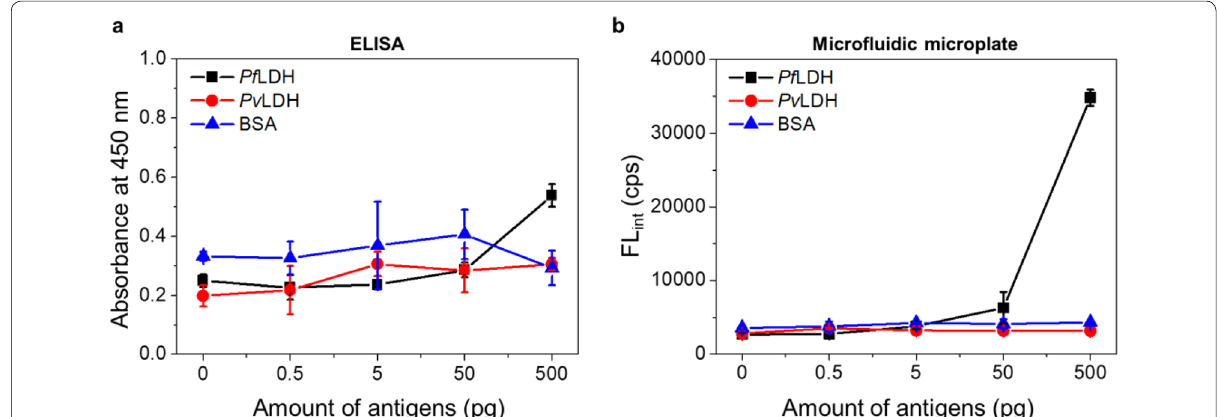
Fig. 6 Diagnosis of Pf LDH, Pv LDH, and BSA in human serum using a ELISA and b microfluidic microplate (n range of 0–500 pg in human serum